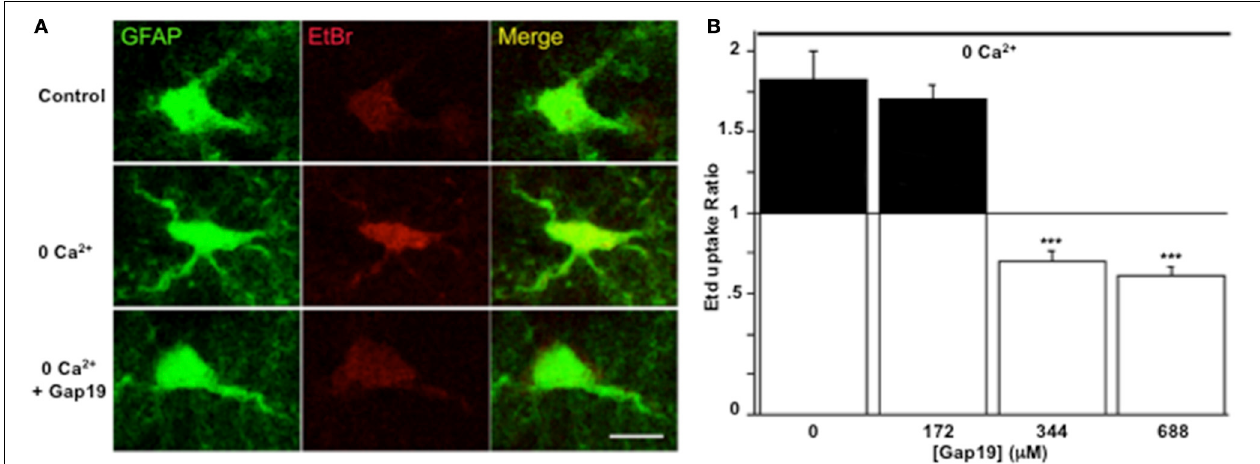
FIGURE 3 | Gap19 inhibits hemichannel activity in astrocytes studied in acute hippocampal slices. (A) Representative images of Etd + uptake (red) in astrocytes (green) in hippocampal slices from GFAP-eGFP transgenic mice, under control conditions (upper row) and after 10min exposure to a Ca 2 + -free solution without (middle row) or